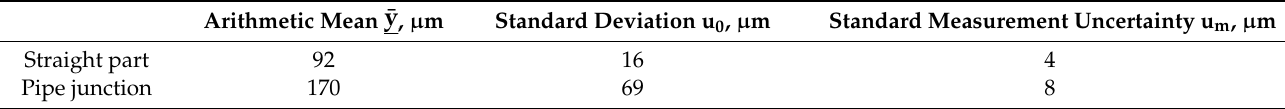
Table 1. Coating thickness measurement results.